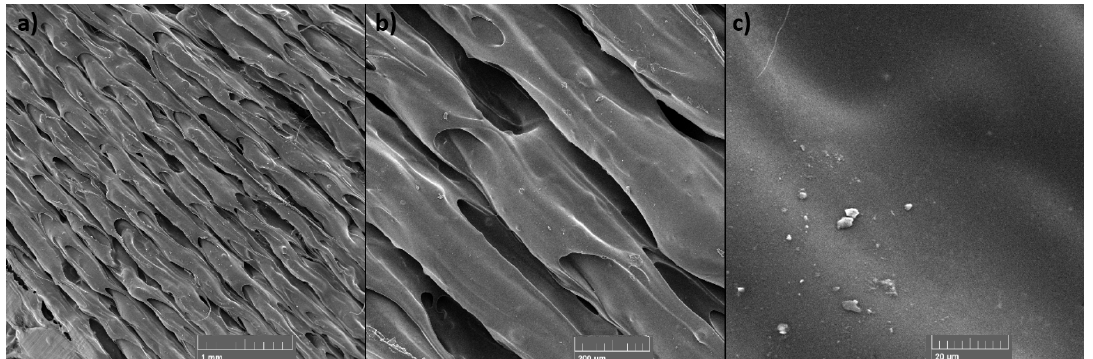
Figure 15. SEM micrographs of the 3D-printed static mixer for the PET-G 3T 0C sample at ( a ) 50×, ( b ) 200× and ( c ) 2000× magnification .